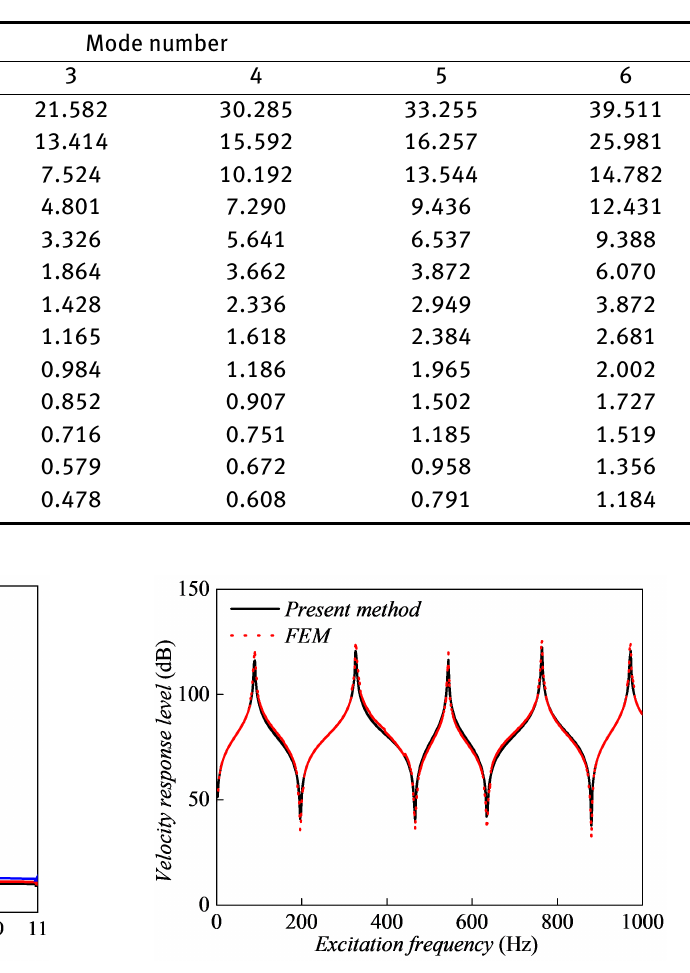
Table 7: The first six natural frequencies for the rectangular thin plate with C-C-F-F boundary condition and different aspect ratios.